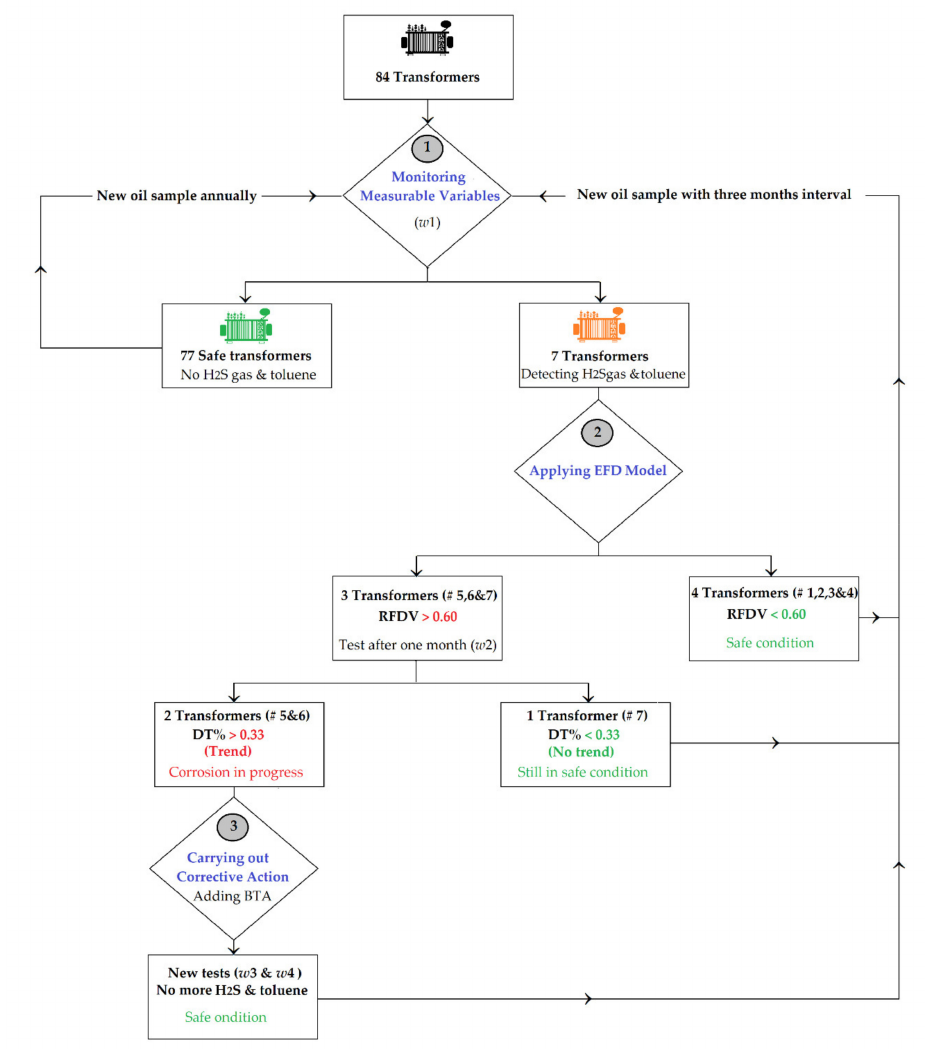
Figure 6. Flow diagram showing the process of the applied CM procedure in the PSMD power plant. Monitoring the measurable variable was the first step, where H 2 S gas and toluene were detected in 7 transformers among 84. The second step was applying the EFD method where the RFDV was >0.60 in three transformers. After one month, two of these three transformers were diagnosed with suspected copper corrosion propagation based on DT% which was >0.33. The last step was adding a passivator BTA to these two transformers to suppress the corrosion reaction. w 1 = first measured value, w 2 = second measured value after one month, w 3 and w 4 = measured values after adding passivator, EFD = Early Fault Diagnosis, REDV = Relative Fault Detection Value, DT% = Daily Trend, BTA = Passivator Benzo